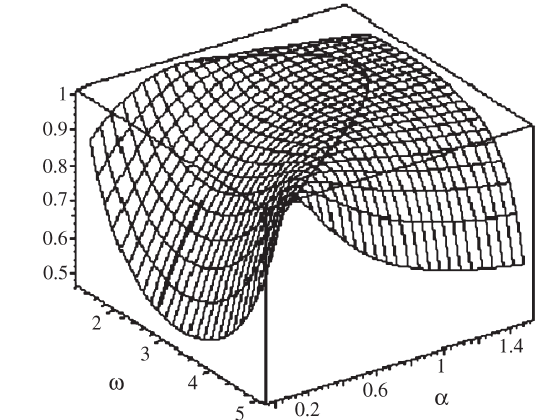
Figure 2 - The surface ρ ( ω , α ). There is a curve of maxima represented by a full line. The global minimum is ( π